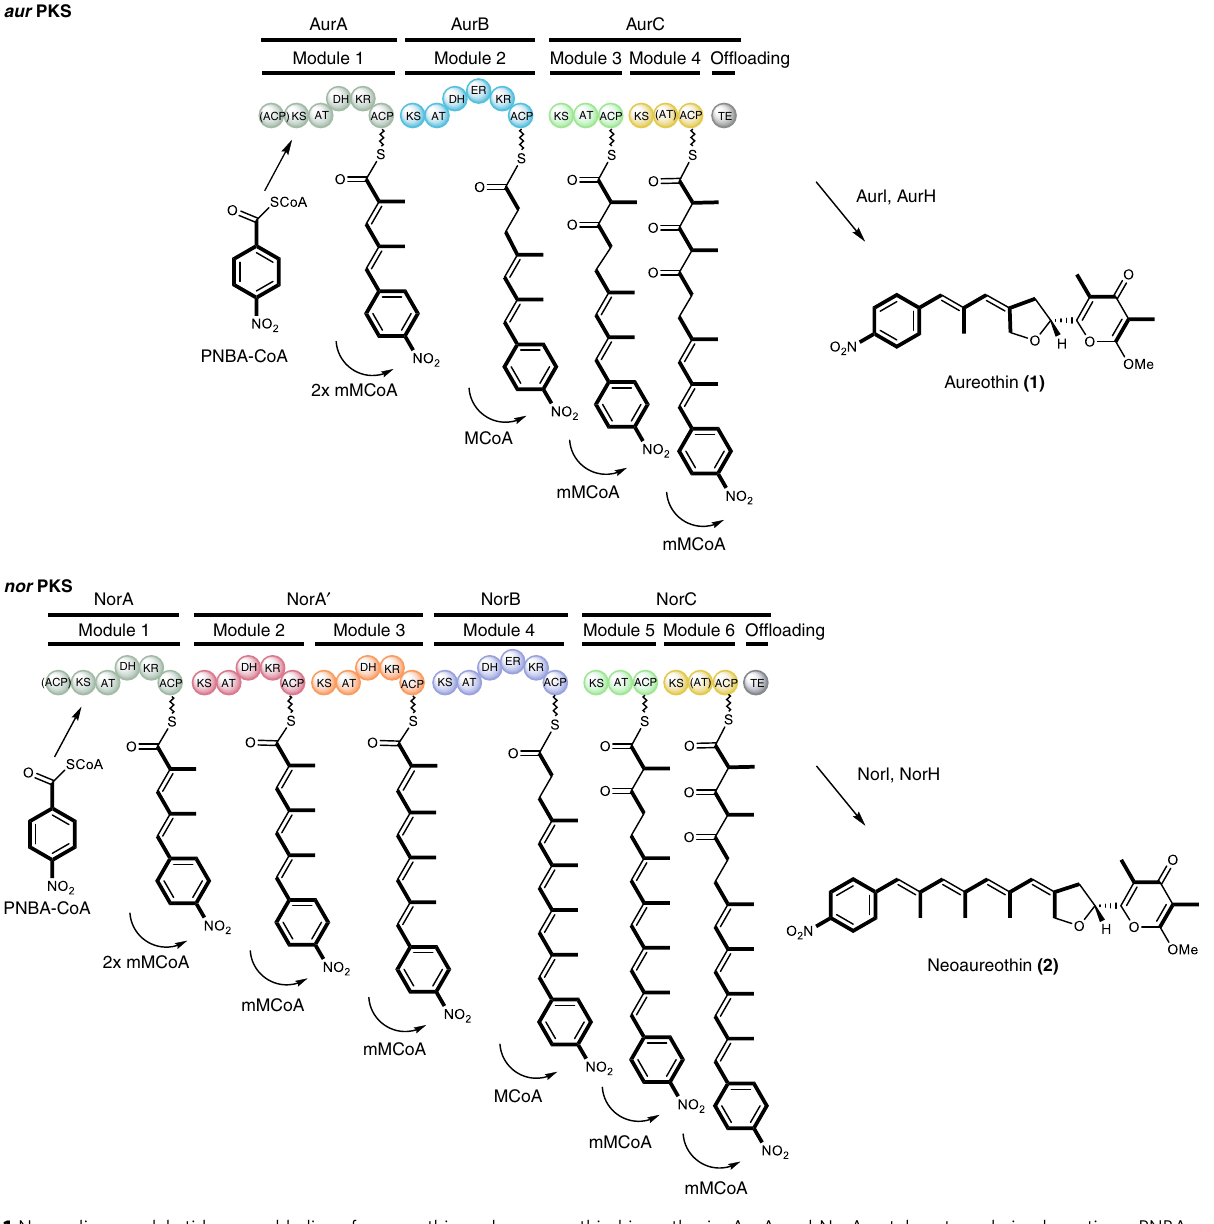
Fig. 1 Non-colinear polyketide assembly lines for aureothin and neoaureothin biosynthesis. AurA and NorA catalyze two chain elongations. PNBA: p - nitrobenzoic acid, mM-CoA: methylmalonyl-CoA, M-CoA: malonyl-CoA, KS: ketosynthase, AT: acyltransferase, DH: dehydratase, ER: enoylreductase, KR: ketoreductase, ACP: acyl carrier protein, TE: thioesterase. The inactive domains in (AurA/NorA) and (AurC/NorC) are indicated with brackets. Color code in module indicates homologous proteins (except for AurB (cyan) and NorB (purple), for which different colors are used to distinguish the engineered site in Figs. 3d and 5.) These color codes correspond with those shown in Fig.